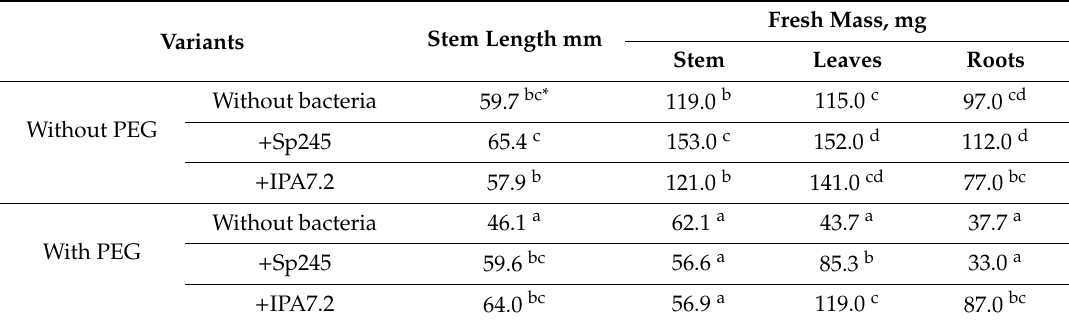
Table 1. The e ff ect of bacteria ( A. brasilense Sp245 and O. cytisi IPA7.2) morphological parameters of plants grown with or without PEG measured after 22 days of microplant cultivation.